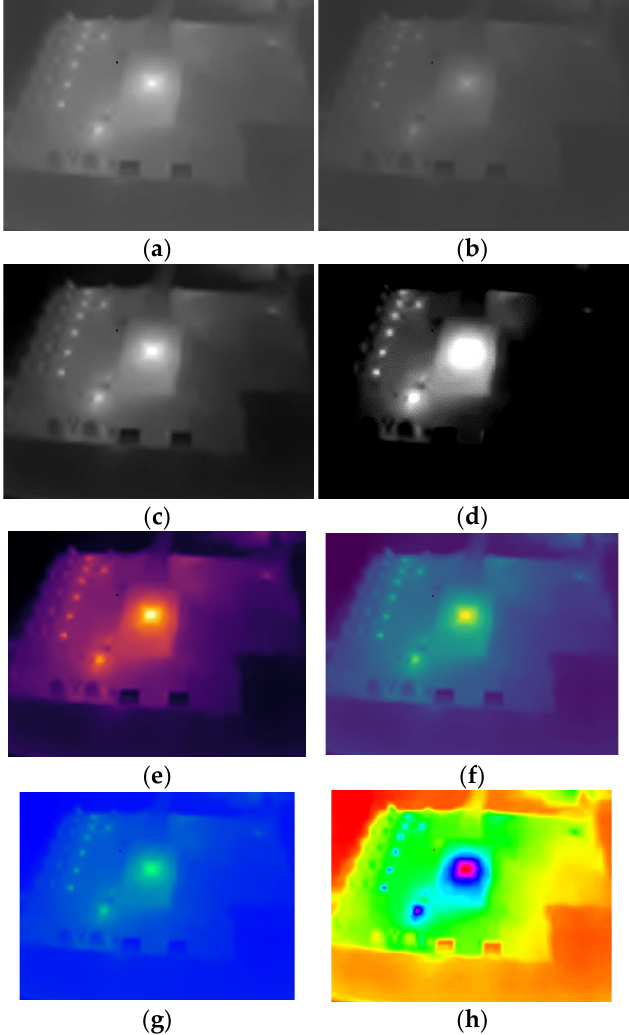
Figure 17. IRT images generated from estimated radiometric data ( a – d ) and IRT images generated from estimated radiometric data using different color maps ( e – h ). LB represents a low-temperature boundary and HB represents a high-temperature boundary. ( a ) Generated image: LB: 18, HB: